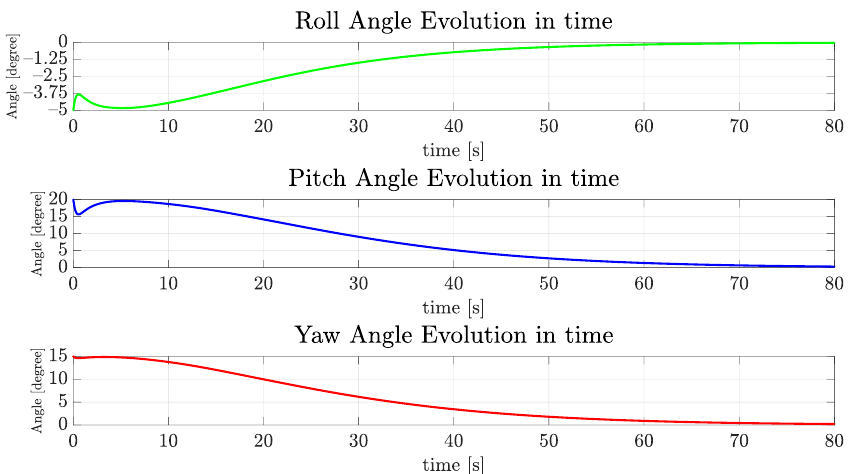
Figure 16. The evolution of orientation components of the simulated vehicle over time for the straight path.